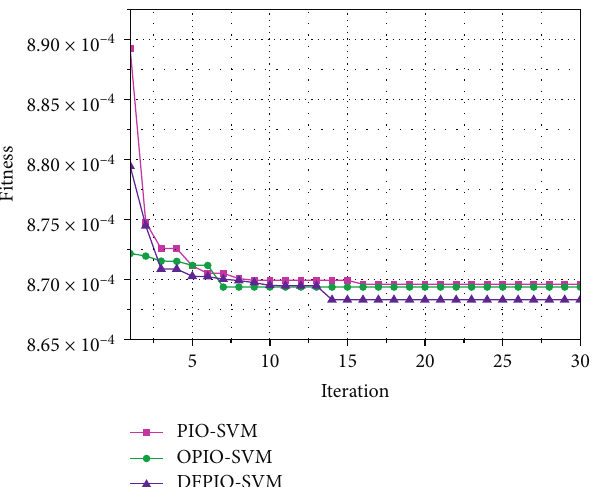
Figure 12: Iterative curves of three optimization